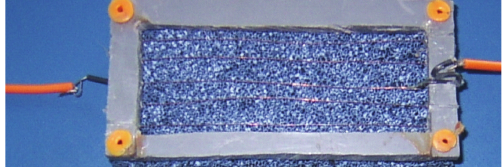
Figure 4: The hybrid configuration and catalyst film.